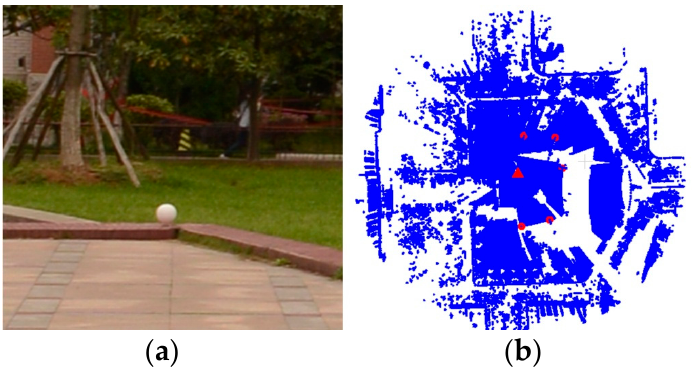
Figure 6. The spherical targets of data set 1. ( a ) the used target (white sphere). ( b ) the distribution of the targets (red circle points). The red triangle denotes the scan station.